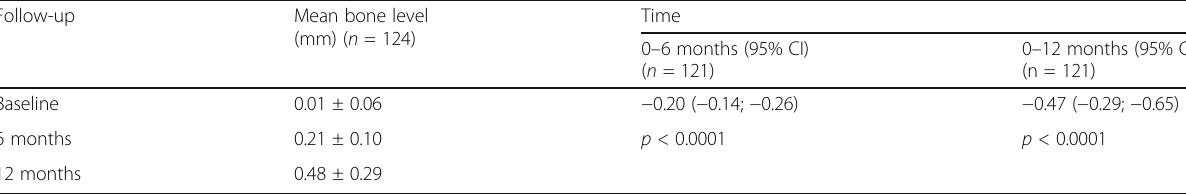
Table 3 Comparison of mean bone levels (means ± SD) at different follow-up intervals Follow-up